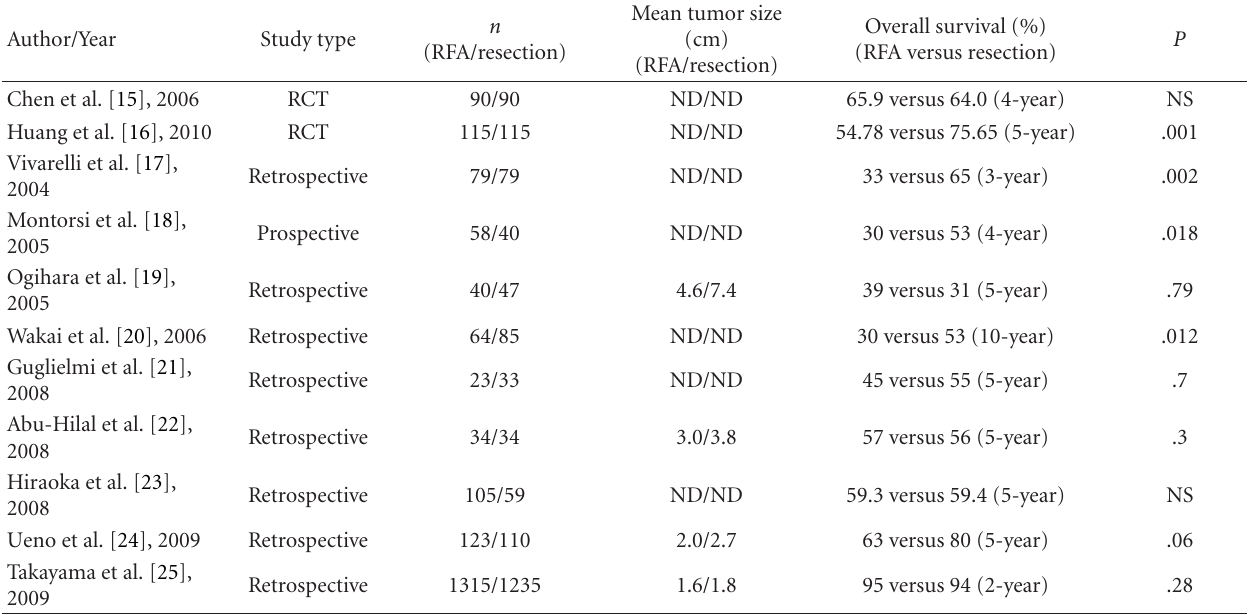
Table 1: Survivals: RFA versus hepatic resection for HCC.